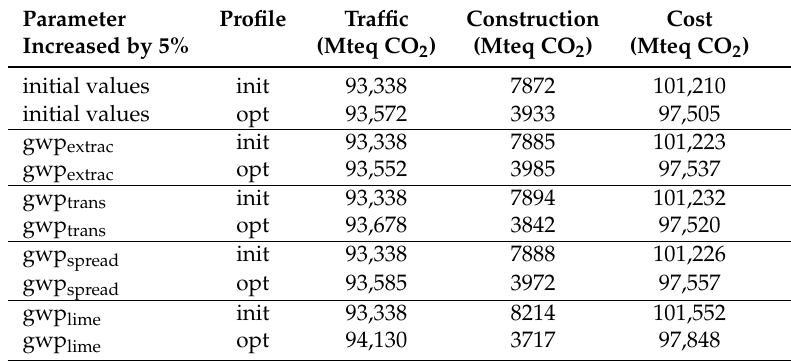
Table 6. Sensitivity analysis on construction